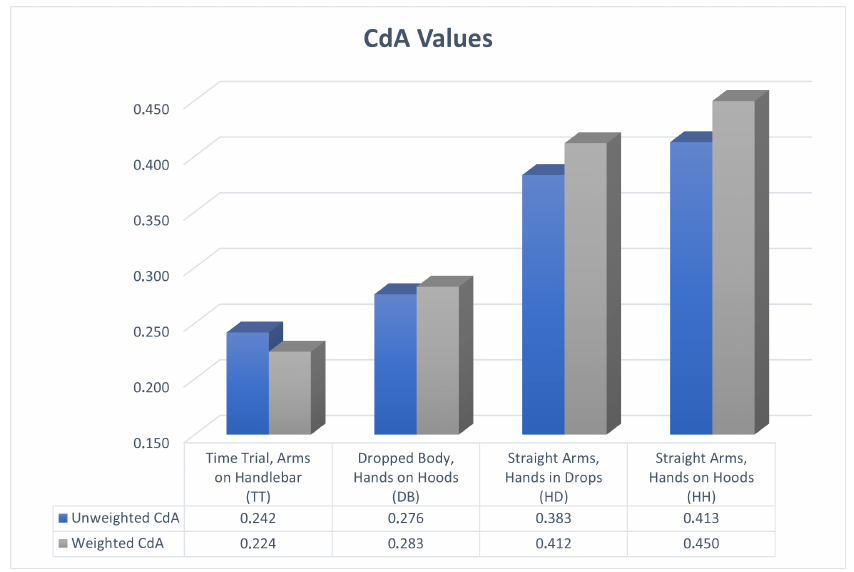
Figure 10. Comparison of yaw-averaged and yaw-weighed CdA values.